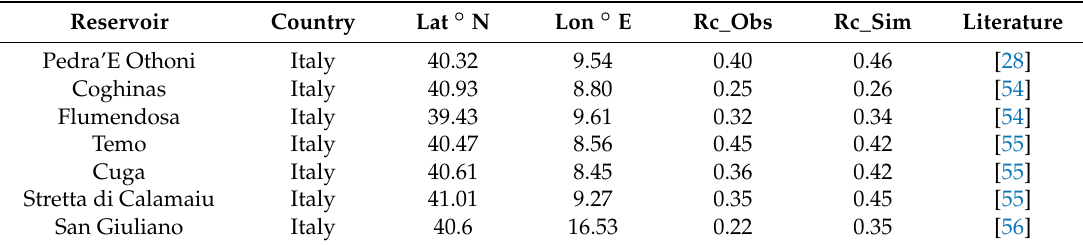
Table 2. Comparison of observed (Rc_obs) and simulated (Rc_sim) runoff coefficient for specific Italian reservoir upstream basins.